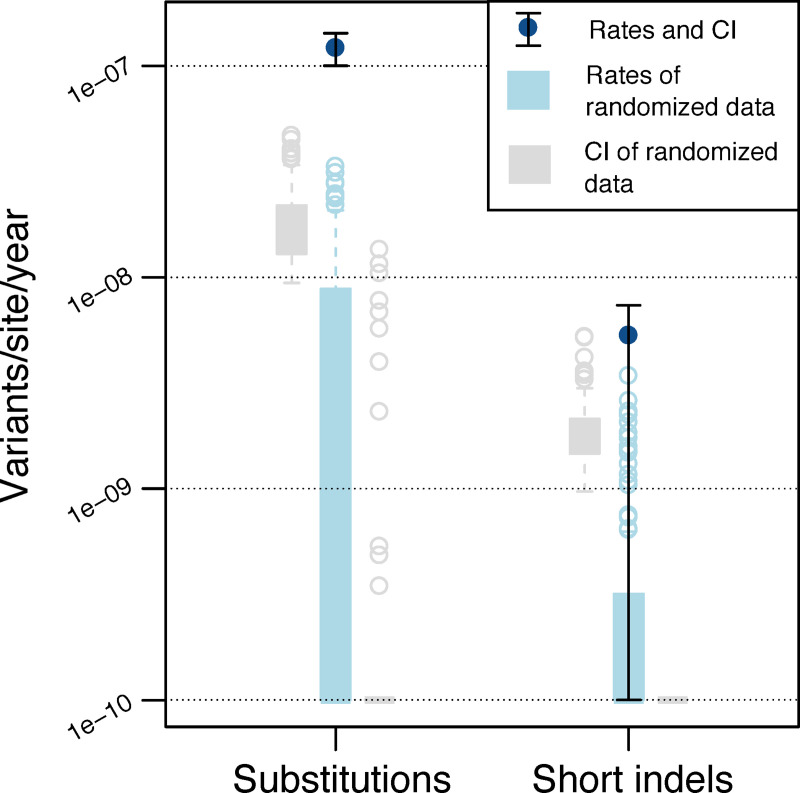
Evolutionary rates of substitutions and short indels and their associated 95% confidence intervals (CI) estimated with LSD for the CAO.Substitution rate was estimated as 1.23e-7 [1.00e-7–1.43e-7] substitutions/site/year and the short indel rate was estimated as 5.37e-9 [1e-10–7.37e-9] indels/site/year. The light colors show the distribution of rates for date-randomized data and their associated lower and upper confidence intervals; information for all randomized data sets are in the supporting information (S8 Fig). For substitutions, there is no overlap in rate and confidence interval between real data and date-randomized data, indicating the presence of temporal signal according to the stringent test. For short indels, the evolutionary rate inferred from the real data does not overlap with the rates of the date-randomized data. However, the confidence interval of the evolutionary rate inferred from the real data overlaps with the upper confidence intervals of the date-randomized data, indicating the presence of temporal signal for short indels according to the simple test. Hence, the temporal signal of short indels is weaker than that of substitutions. Due to the limited number of events, there is not sufficient temporal signal to estimate evolutionary rates for short insertions and deletions separately or for long indels.